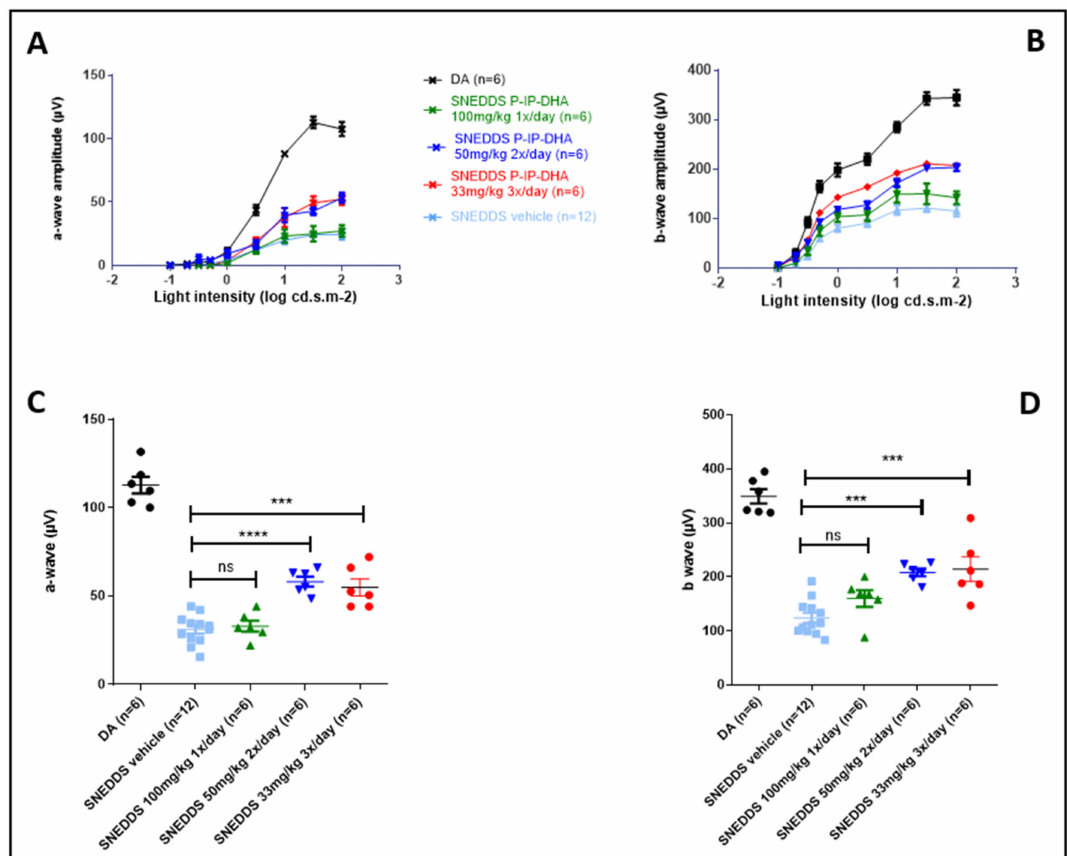
Figure 9. Light intensity of a- ( A ) and b- ( B ) wave of BALB/c mice, and maximum light inten- sity of a- ( C ) and b- ( D ) wave with oral administration of various pretreatments after retinal degeneration-induced chronic blue light stress. One-way ANOVA with Bonferroni’s multicom- parison test: *** p < 0.001, **** p < 0.0001, ns: not